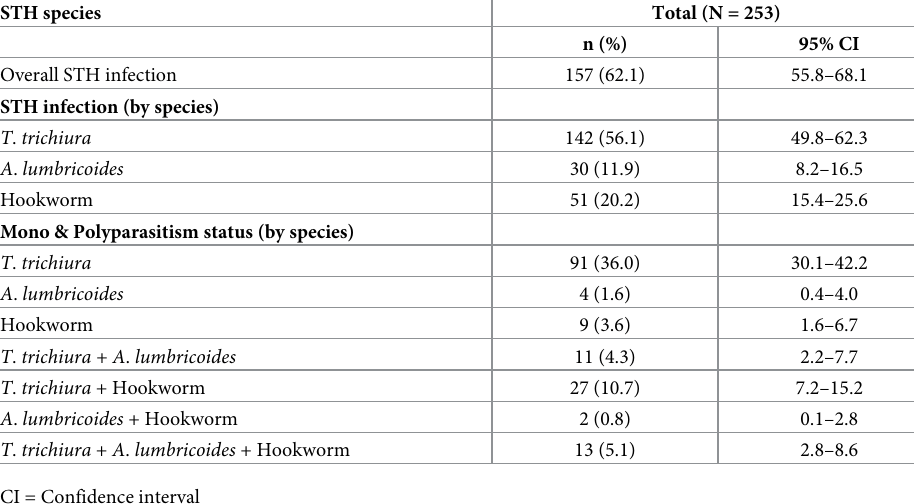
Table 2. Overall STH positivity among Orang Asli community (N = 253).